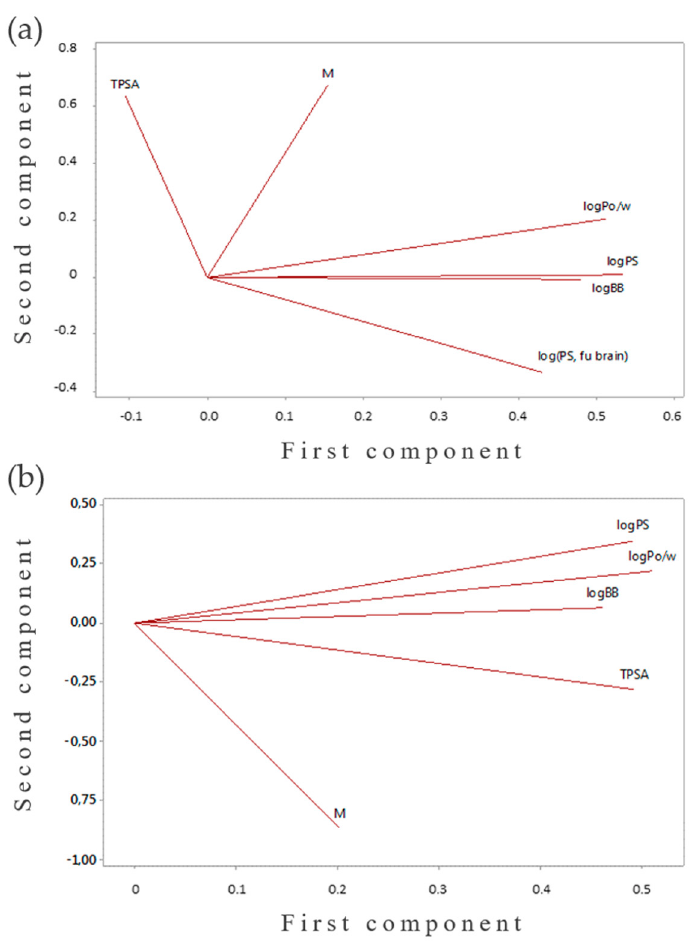
Figure 2. Loading plots of the chosen parameters for: ( a ) aporphine; ( b ) protoberberine alkaloids.